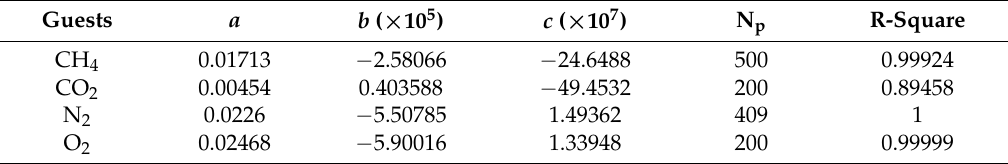
Table 4. Parameters for the correlation of the gas mole fraction in aqueous